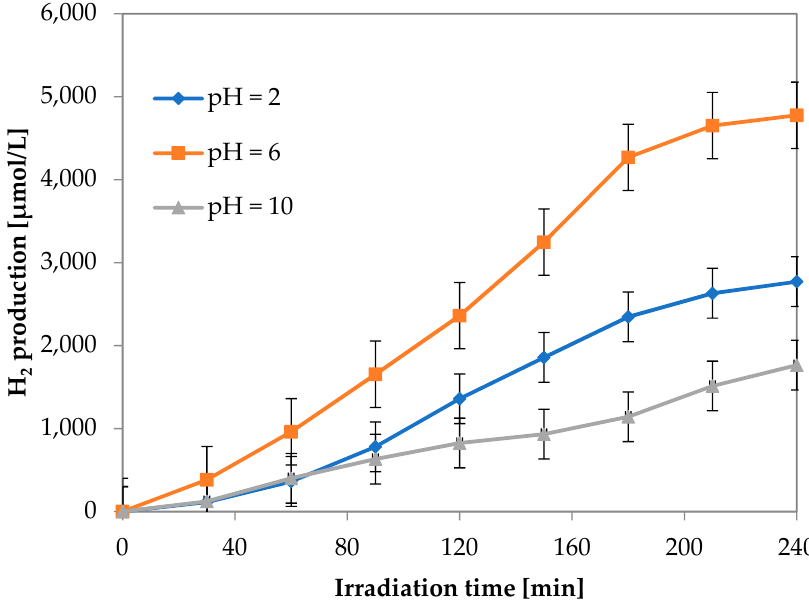
Figure 5. Photocatalytic hydrogen production during the irradiation time at di ff erent initial pH levels of solution. Glycerol initial concentration: 10 wt %; catalyst dosage: 1.5 g / L; visible light intensity: 32 mW / cm 2 ; photocatalyst: 1.08Cu_ZnO.